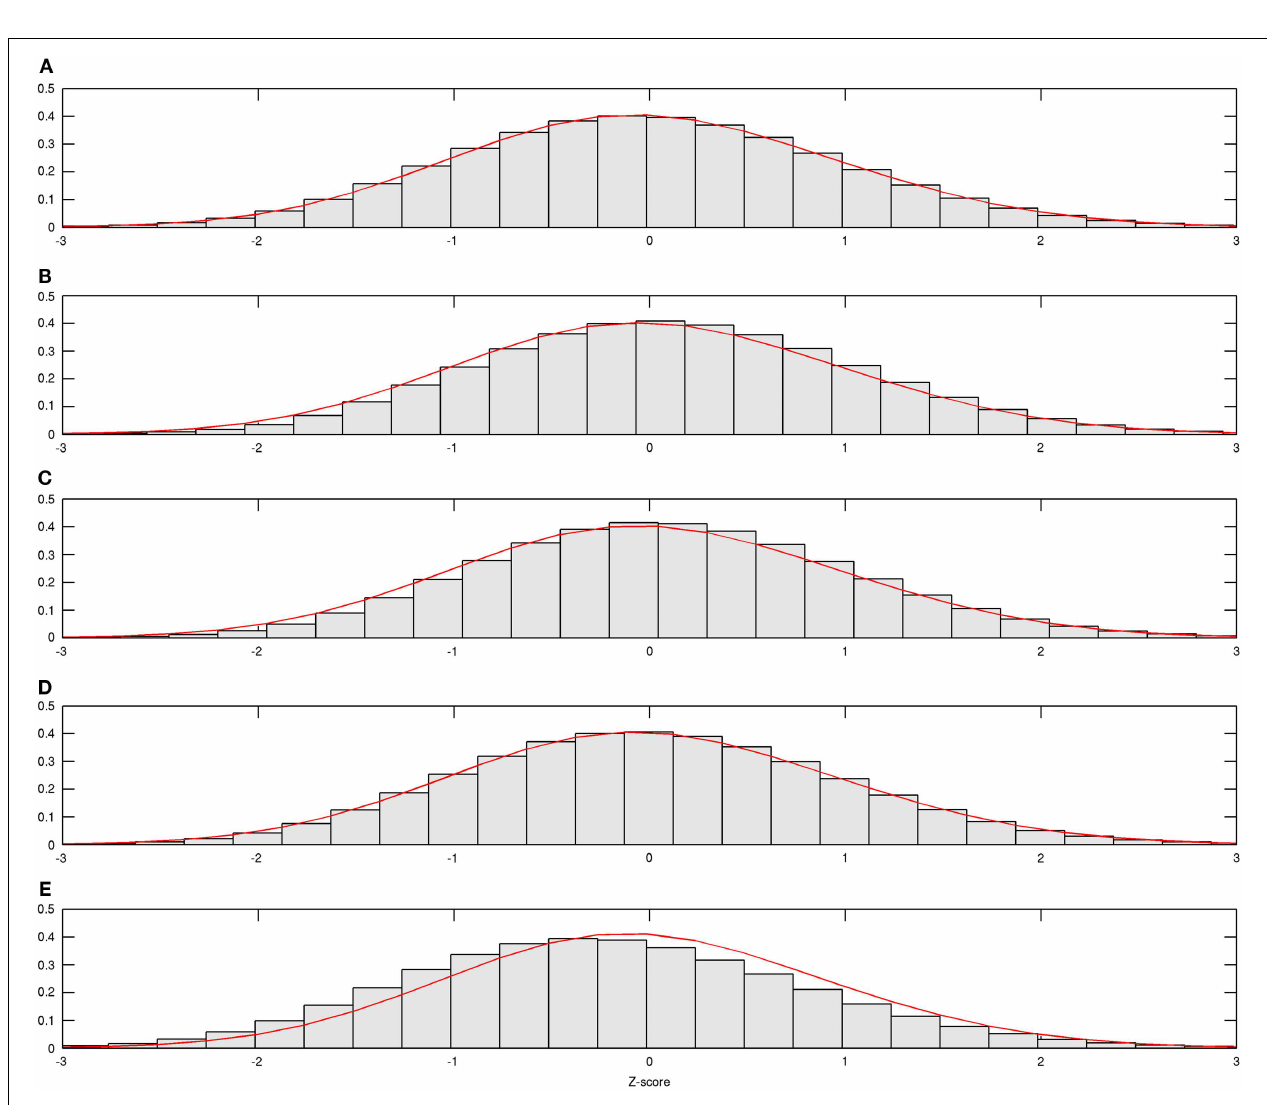
FIGURE 1 | Estimated age group-wise density functions. Estimated density function for all and each age group is demonstrated; (A) from all subjects, (B) from subjects aged 20–29, (C) from subjects aged 30–39, (D) from subjects aged 40–49, and (E) from subjects aged 50–59.